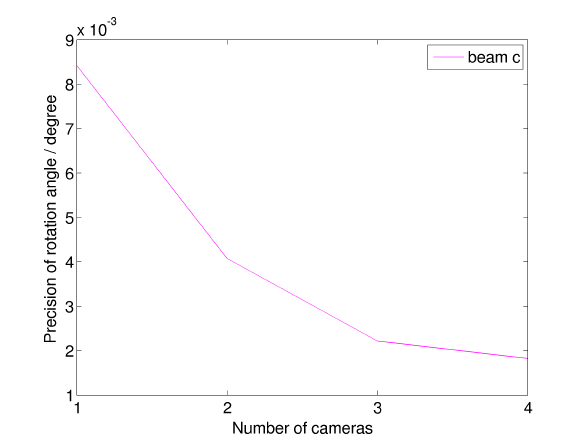
Figure 10: Analytically derived precision of the rotation angle of beam c as a function of the number of